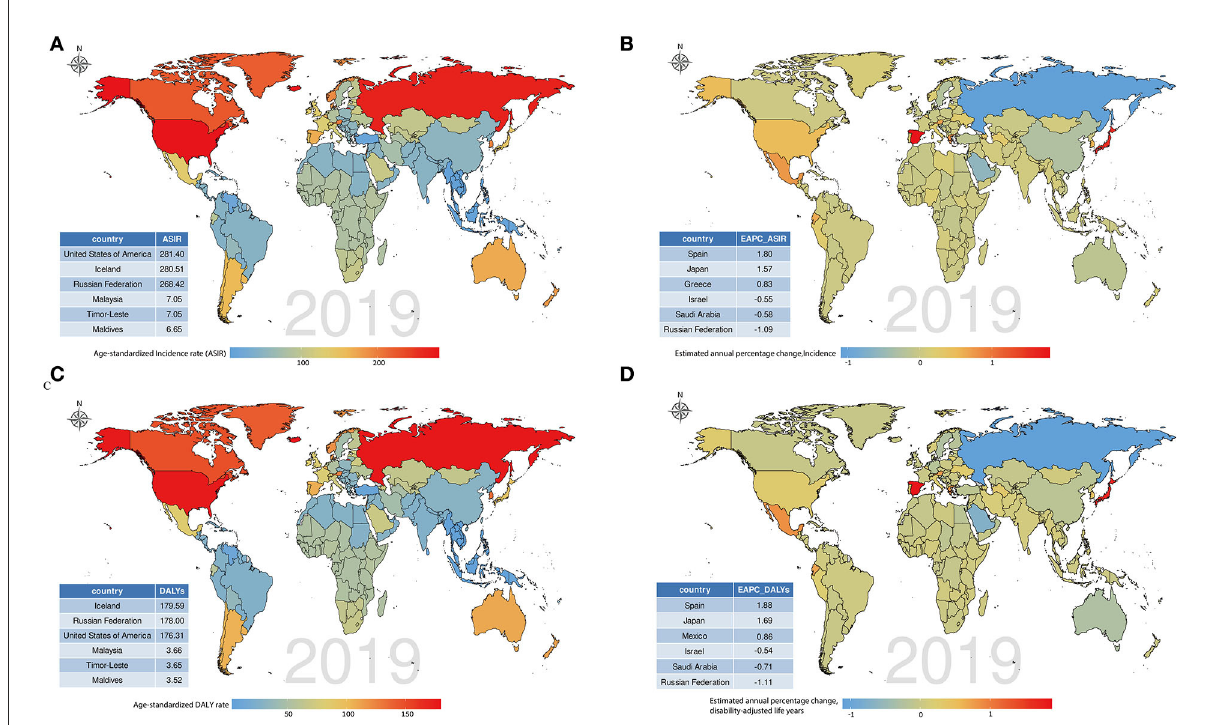
FIGURE5 Global disease burdens of hand osteoarthritis and their estimated annual percentage changes (EAPCs) in 192 countries. (A) The age-standardized incidence rate (ASIR) of hand osteoarthritis in 2019; (B) The EAPCs of ASIR from 1990 to 2019; (C) The age-standardized disability-adjusted life year (DALY) rate of hand osteoarthritis in 2019; and (D) The EAPCs of DALYs from 1990 to 2019. Countries with extremums were annotated in the tabulation at the bottom